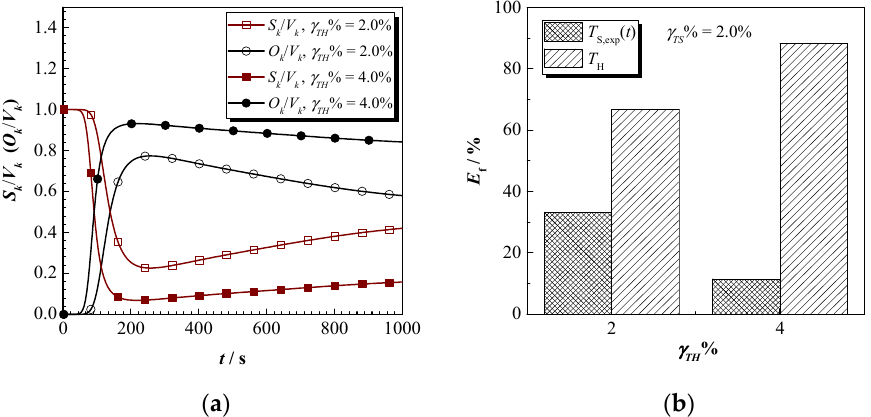
γ values, and ( b ) the error contributions of T S,exp ( t )